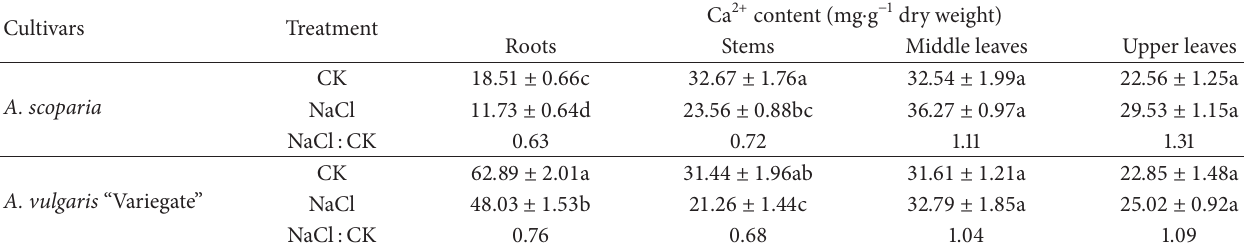
Table 3: Effects of NaCl stress on Ca 2+ content in different organs of A. scoparia and A. vulgaris “Variegate.”